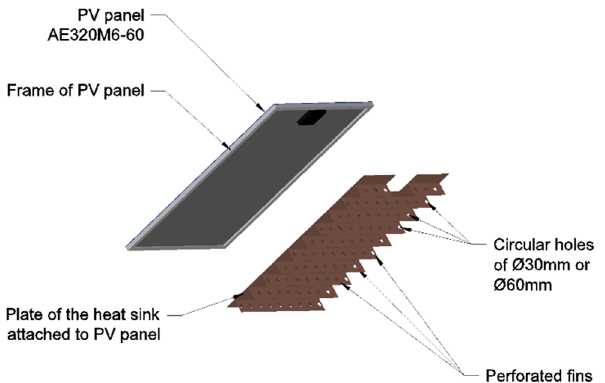
Figure 1. Overview of the components of the heat sink attached to the PV panel for cooling (case with perforated fins).